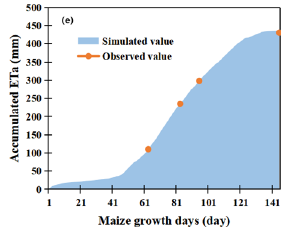
Figure 5. Observational and simulated cumulative ET a during the whole growth period of maize, ( a ) T8, ( b ) T9, ( c ) T10, ( d ) T11, ( e ) T12, ( f ) T13, and ( g ) validation of ET a for different stages (2016– 2017).